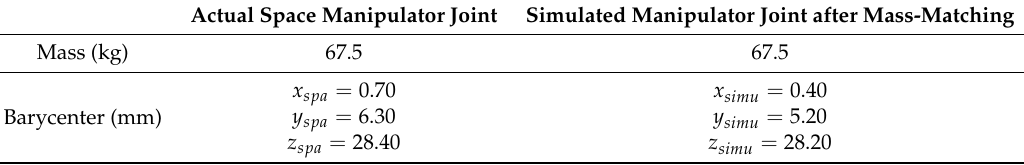
Table 4. Mass parameters of the actual space and simulated manipulator